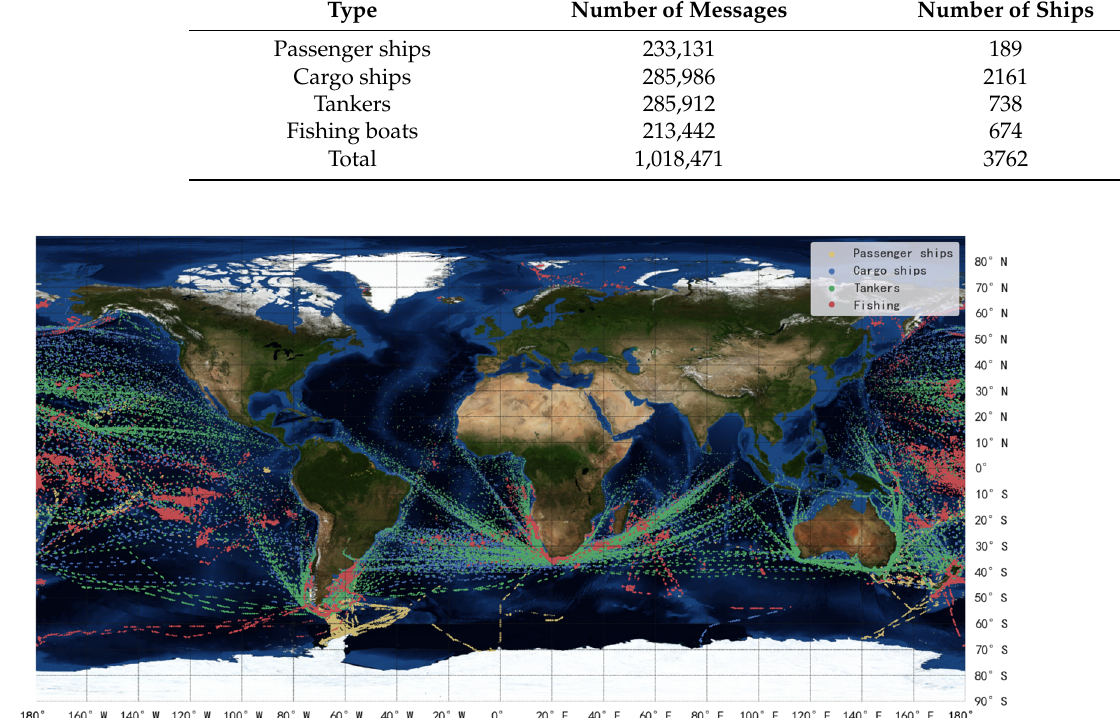
Figure 15. Original dynamic data.